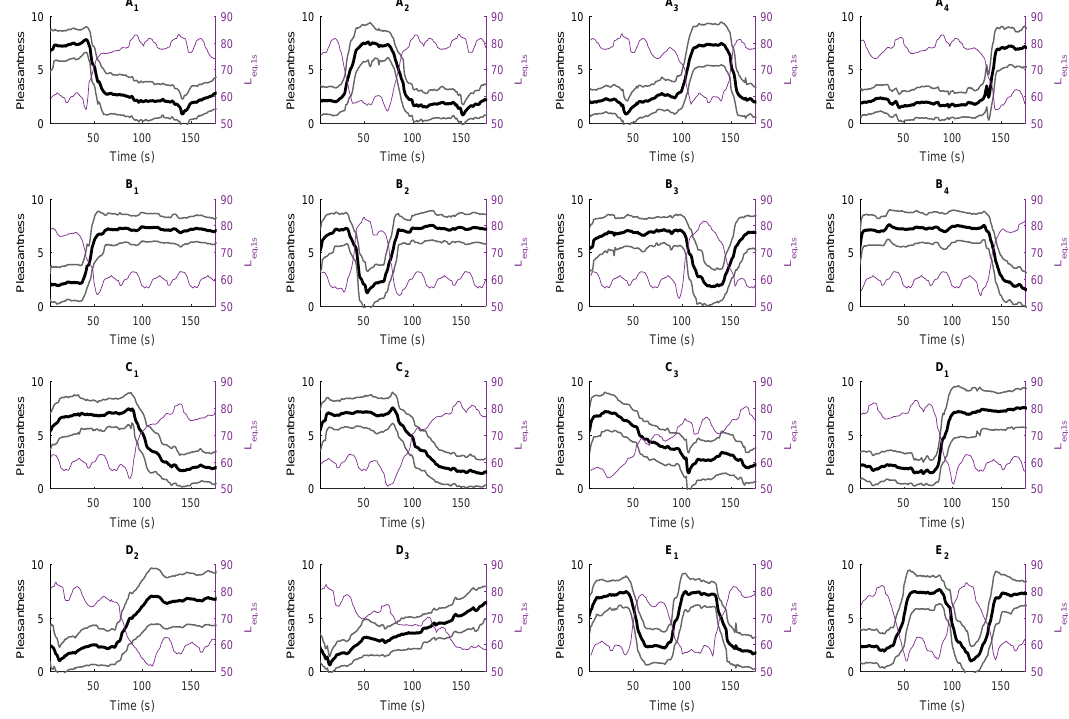
Figure 3. Continuous perceived pleasantness, mean values over participants P mean (thick black line), standard deviations (light black lines), and sound level ( L eq,1s , purple) over time for the 16 sequences.